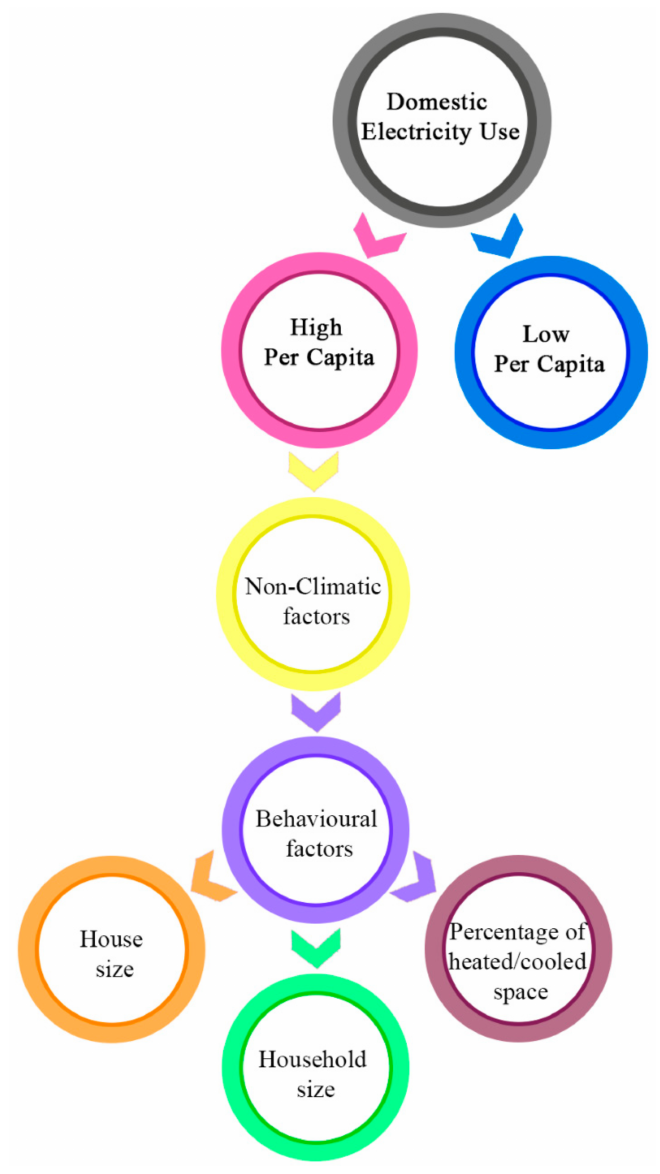
Figure 2. Factors affecting high per capita domestic electricity use in provinces of